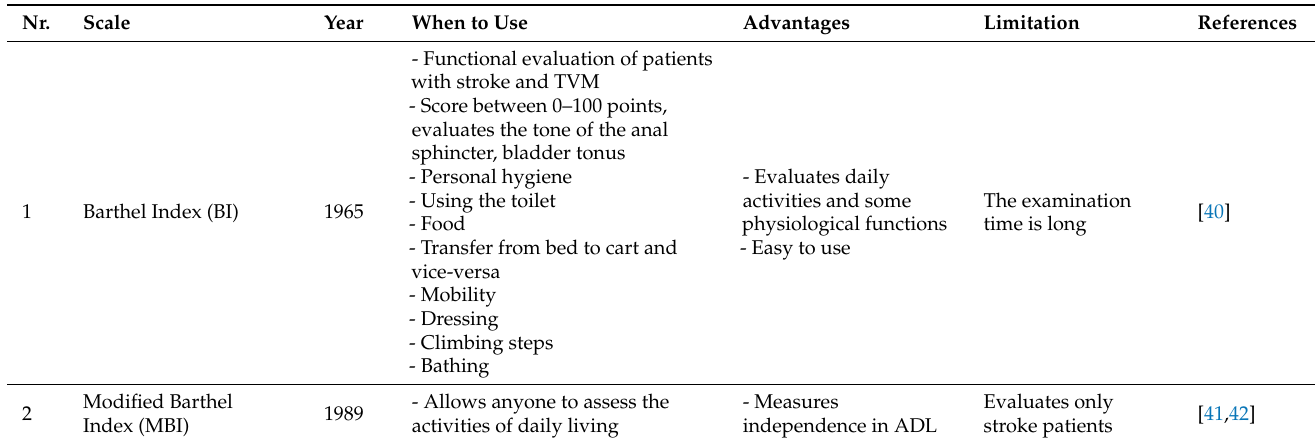
Table 2. Functional evaluation scales of